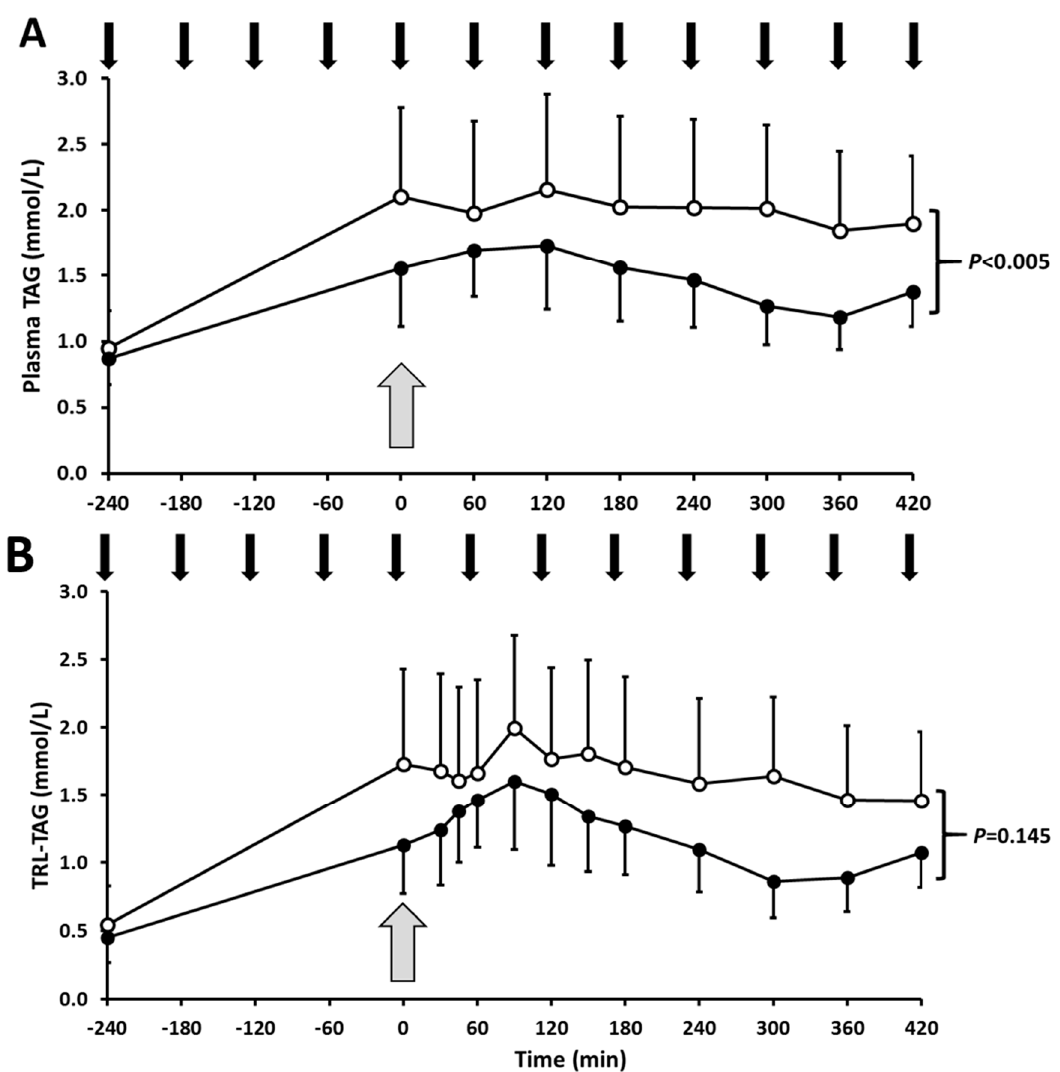
Figure 2. Mean plasma TAG ( A ) and TRL-TAG ( B ) responses to high- or low-fructose drinks. Subjects consumed high-fructose (white circles) or low-fructose (black circles) drinks every hour (black arrows) from fasted ( − 240 min) to achieve a steady postprandial state (0 min; grey arrow), at which time a bolus of [ 2 H 5 ]-glycerol was administered to measure lipoprotein TAG kinetics (0–420 min). Data are mean ± SEM. Time course responses were analysed by a linear mixed model to determine the treatment effect: for plasma TAG P < 0.005; for TRL-TAG P = 0.145 (NS). TAG, triacylglycerol; TRL, triacylglycerol-rich lipoproteins.